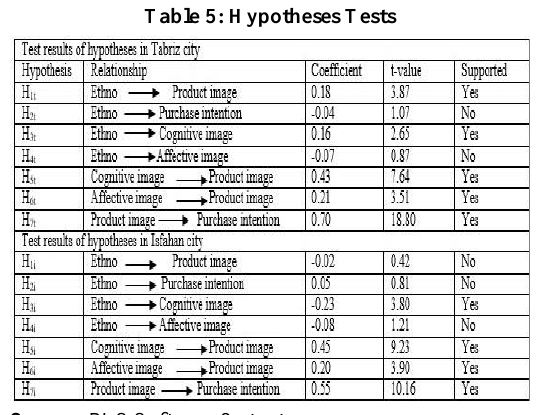
Table 5: Hypotheses